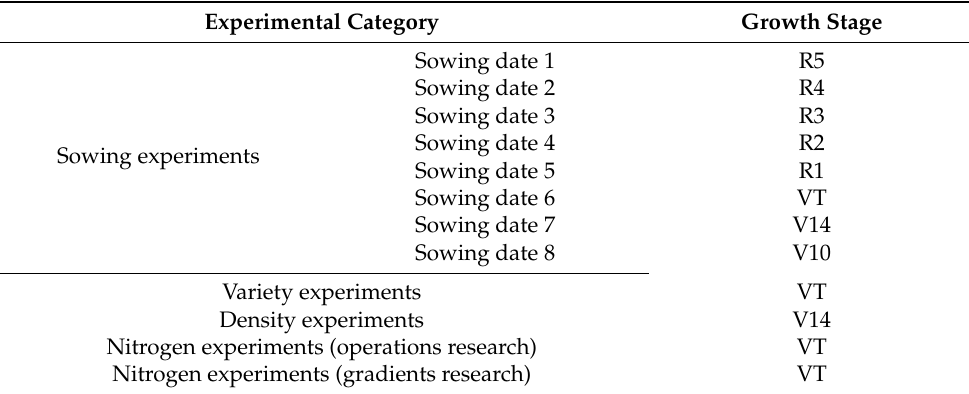
Figure 1. Distribution of experimental plots A-1, A-2, A-3, A-4, A-5. Table 1. Nitrogen treatment application methods. Table 2. Investigation details of growth period during maize